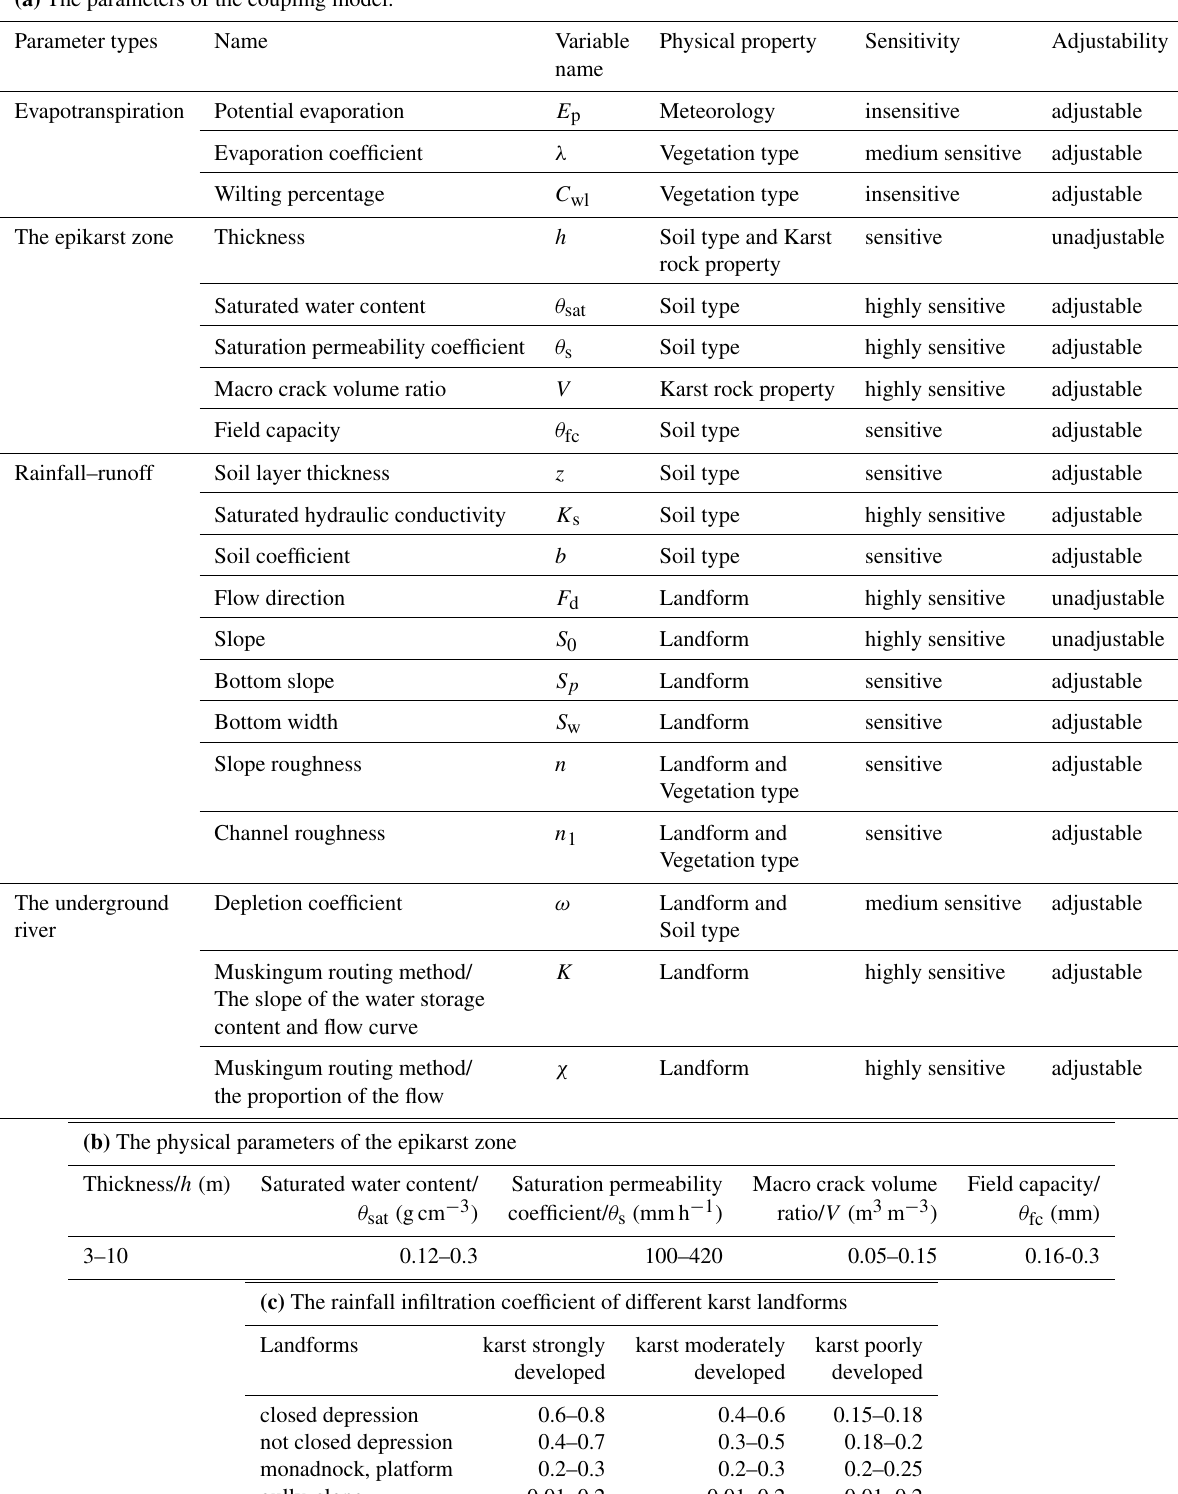
Table 2. The parameters of the model. (a) The parameters of the coupling